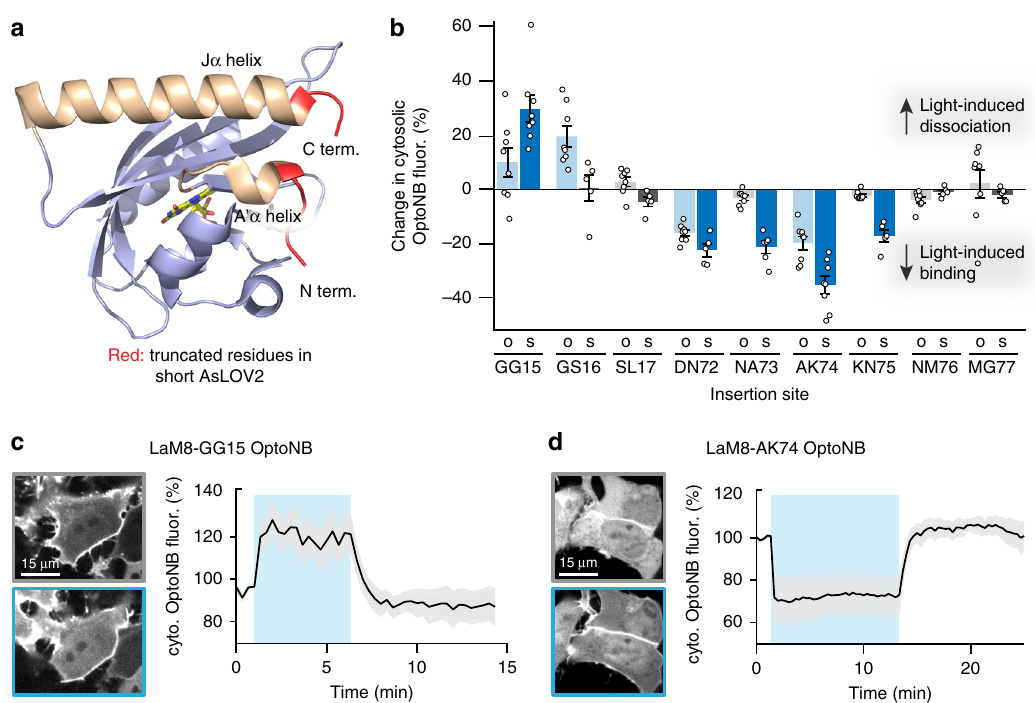
Fig. 2 An optimized short-LOV domain for OptoNB engineering. a AsLOV2 crystal structure (PDB ID: 2V0U) indicating amino acids removed (red) to generate the optimized short AsLOV2 (408 – 543) for nanobody insertions. b Comparison of photoswitchable OptoNB binding in original AsLOV2 ( ‘ o ’ ) and short AsLOV2 ( ‘ s ’ ) for 9 insertion sites near the original two hits, GG15 and AK74. Blue bars indicate a light-induced change; gray bars indicate no photosensitive response. Error bars indicate the mean + SEM of the light-induced change in cytosolic intensity for n = 8 cells per variant. c , d Light-induced membrane/cytosol translocation in HEK293T cells for the LaM8-AK74 (in c ) and LaM8-GG15 (in d ) OptoNBs. The percent change in cytosolic intensity from the original, dark-equilibrated value is shown. Curves and shaded regions indicate mean ± SD for n = 10 cells per variant. Source data are available as a Source data fi